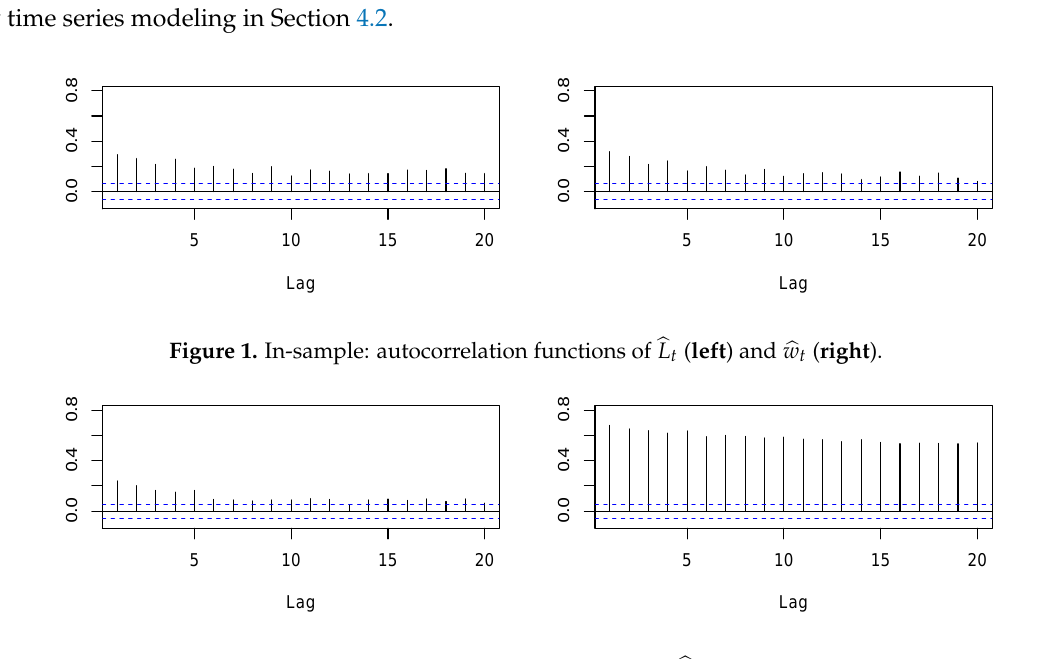
Figure 2. Out-of-sample: autocorrelation functions of (cid:98) L t ( left ) and (cid:98) w t ( right ).